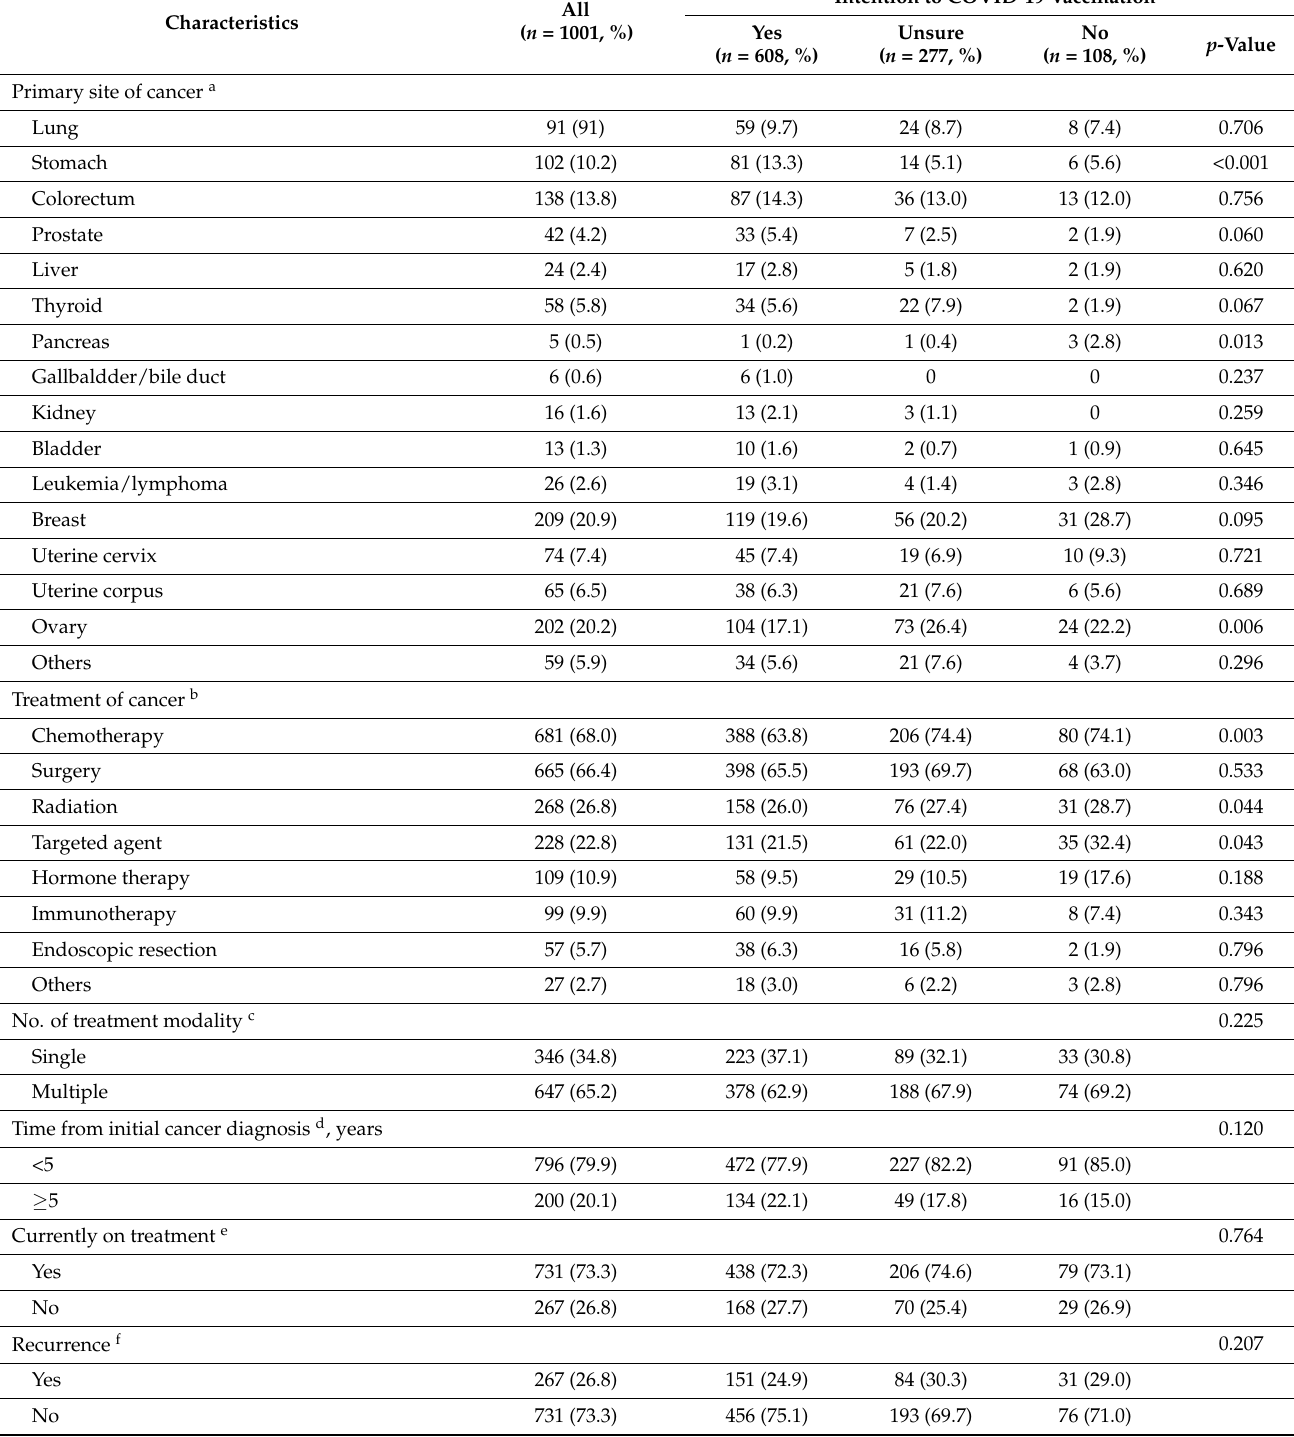
Table 2 provides detailed information on cancer diagnosis and the treatment of all cancer patients and the intention to receive COVID-19 vaccination. Chemotherapy (68.0%) was the most commonly administered treatment modality, followed by surgery (66.4%) and radiation (26.8%). Immunotherapy was conducted in 9.9% of patients. At the time of the survey, 26.8% had recurrent disease, and 73.3% were on cancer treatment. Table 2. Cancer diagnosis and